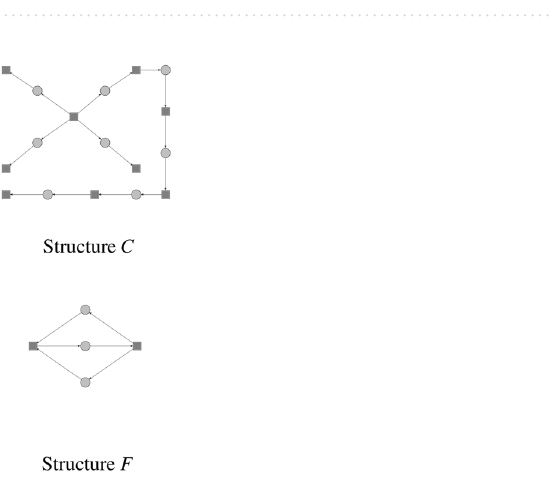
Figure 12. Diagrams in right-bottom part created for all extensions, show changes in behavior of GDDA in relation to net size (Data used for diagrams can be found in Tables S4–S9 from Supplementary Material). Heatmaps in right-top part show distance in GDDA values between each pair tested extensions 20 .